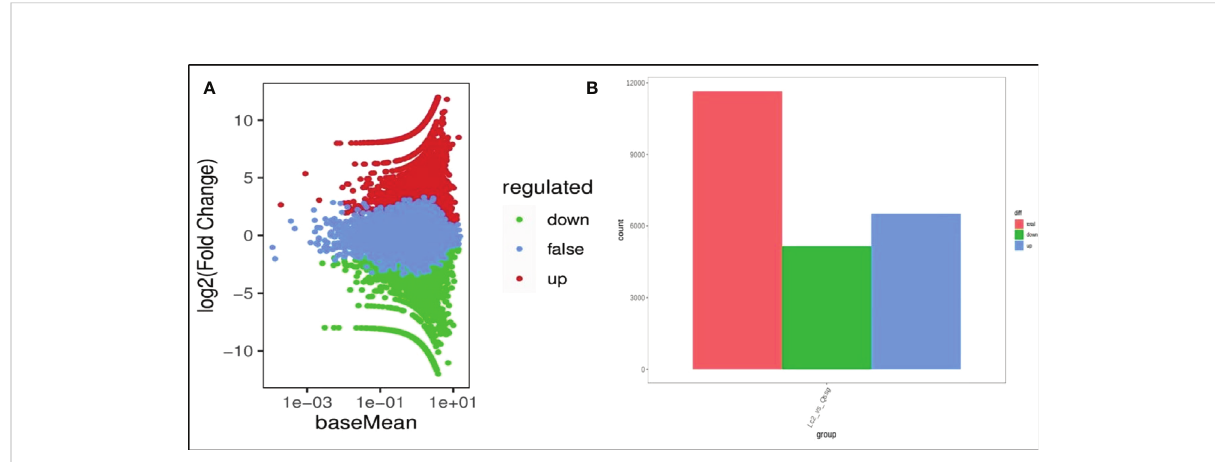
FIGURE 4 Differential gene expression between Qssg and Lc Actinidia arguta Sieb.Zucc .. (A) MA map of differential genes between Qssg and Lc fruits. (B) Columnar chart of the differential gene number in Qssg and Lc